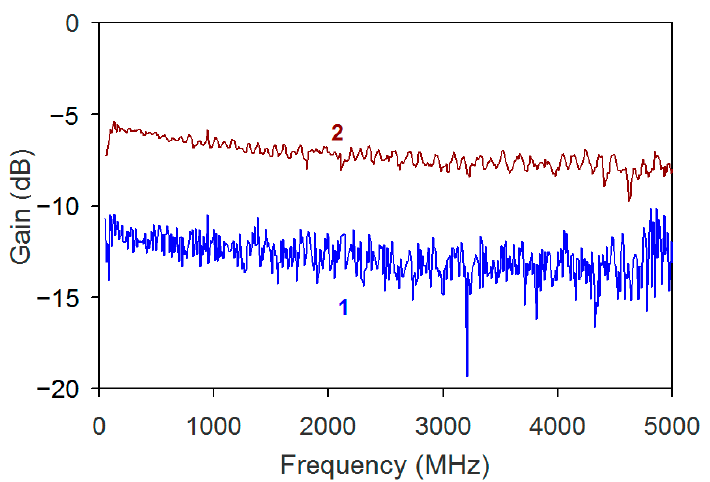
Figure 3. Frequency dependence of the optic link (gain). (1) is the standard mode of amplitude modulation with direct detection, (2) is the balanced mode. modulation with direct detection, (2) is the balanced